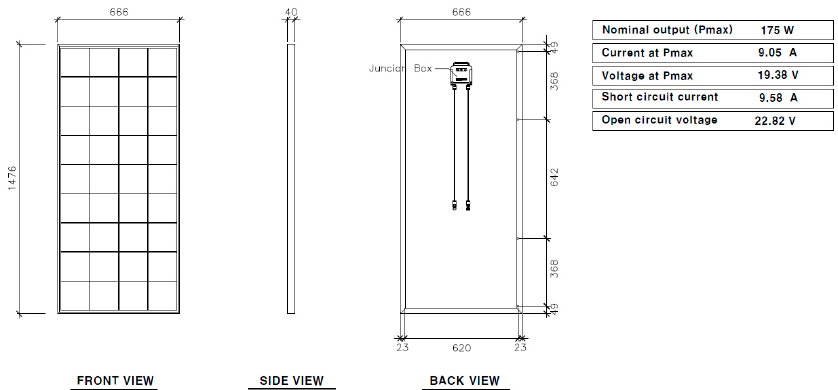
Figure 12. Normal-panel specification (Section B).